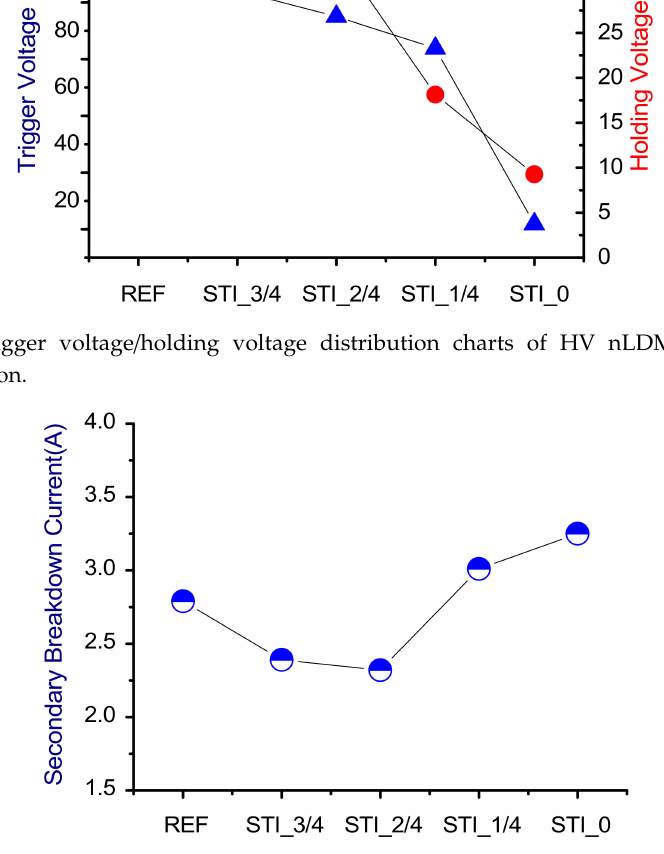
Figure 11. Secondary breakdown-current distribution chart of HV nLDMOSs with drift- region